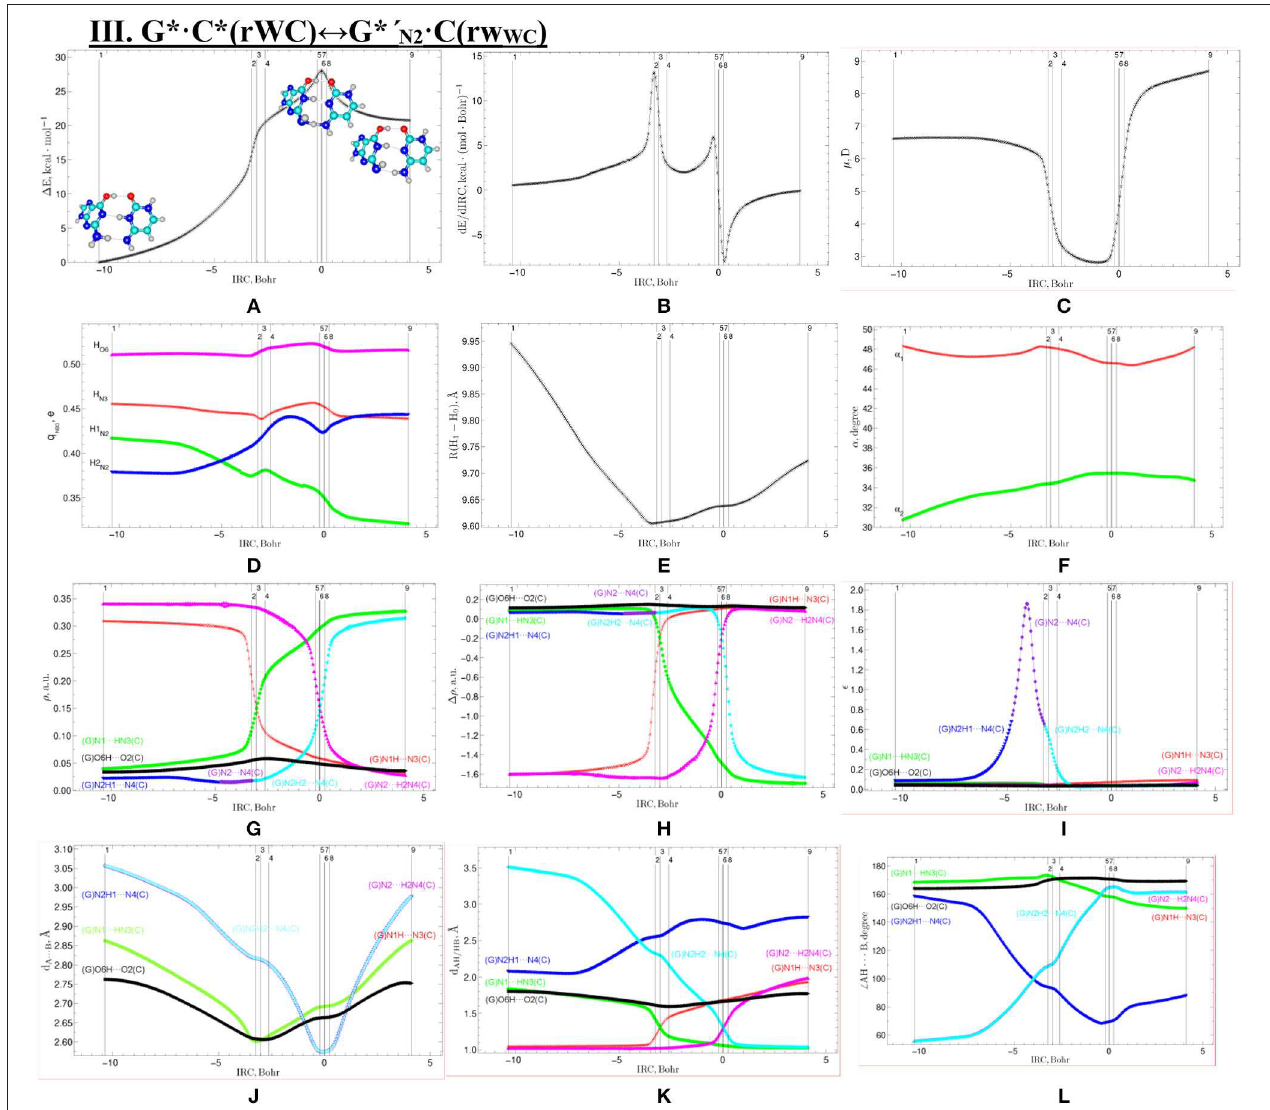
C(rWC) tautomerisation via the DPT obtained at the C*(rWC) G* ′ N2 · · ↔